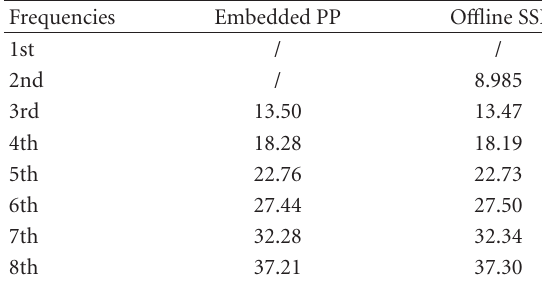
Table 4: Comparisons of the identified frequencies of the cable by embedded PP and o ffl ine